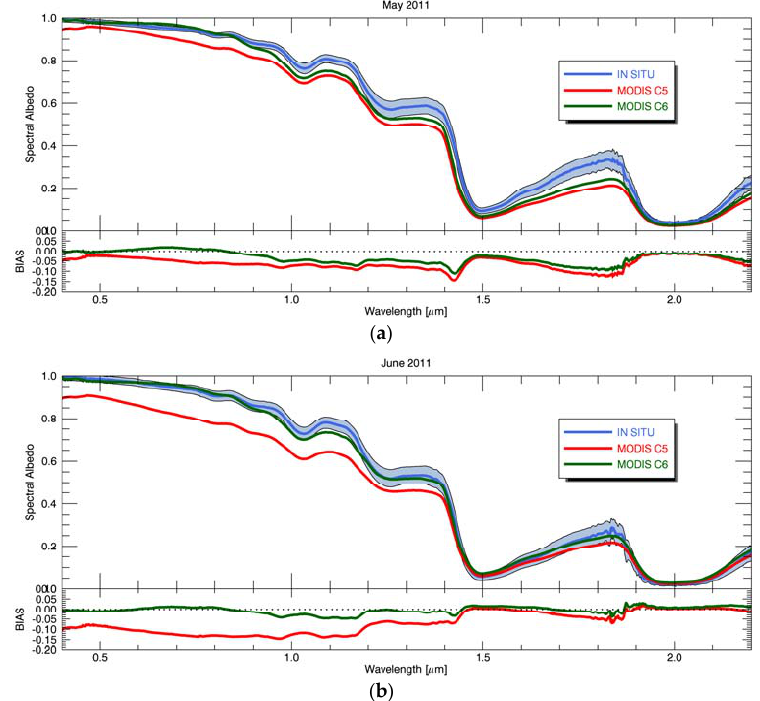
Figure 7. ( a ) Snow spectral albedo (top) and bias (bottom) between then mean spectral albedo measured by the ASD spectroradiometer in May (blue line), and black lines represents the +/ − standard deviation. The spectral albedo from C5 and C6 are represented in red and green, respectively; ( b ) Same as ( a ) for June. for